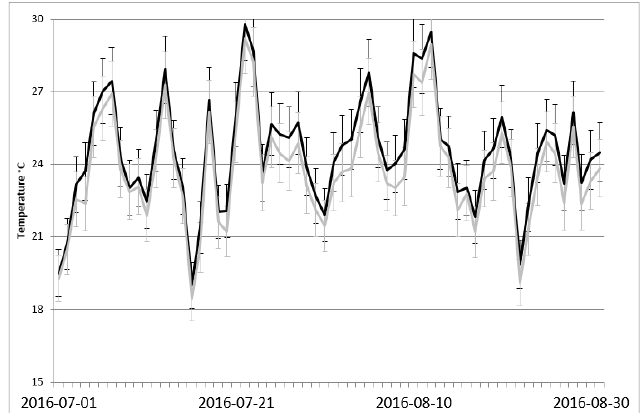
Figure 4. Daily average near-surface air temperature (°C) for control and treatment across all sites for the 2016 summer season. Error bars signify 5% of the measured value, which is consistent with the detection limits of the instrumentation [6].